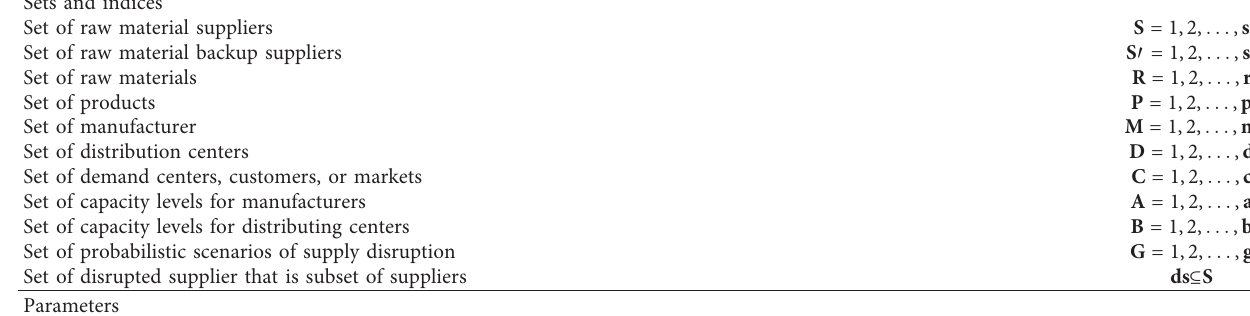
Table 2: Indices, parameters, and decision